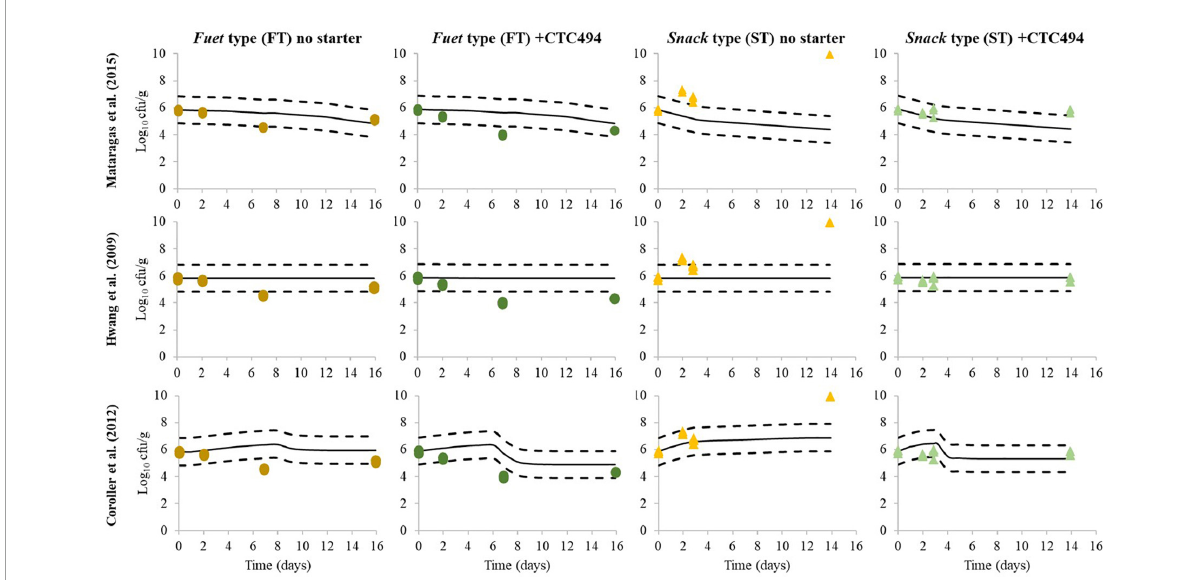
FIGURE4 Simulation of L. monocytogenes behavior during the fermentation and ripening of fuet -type (FT) and snack-type (ST) chicken sausage without starter culture and with the bioprotective L. sakei CTC494 culture, applying predictive models available in the scientific literature. Continuous line represents model predictions, dashed line represents ± 1 Log 10 interval and dots represent the experimentally observed results in the present challenge test.